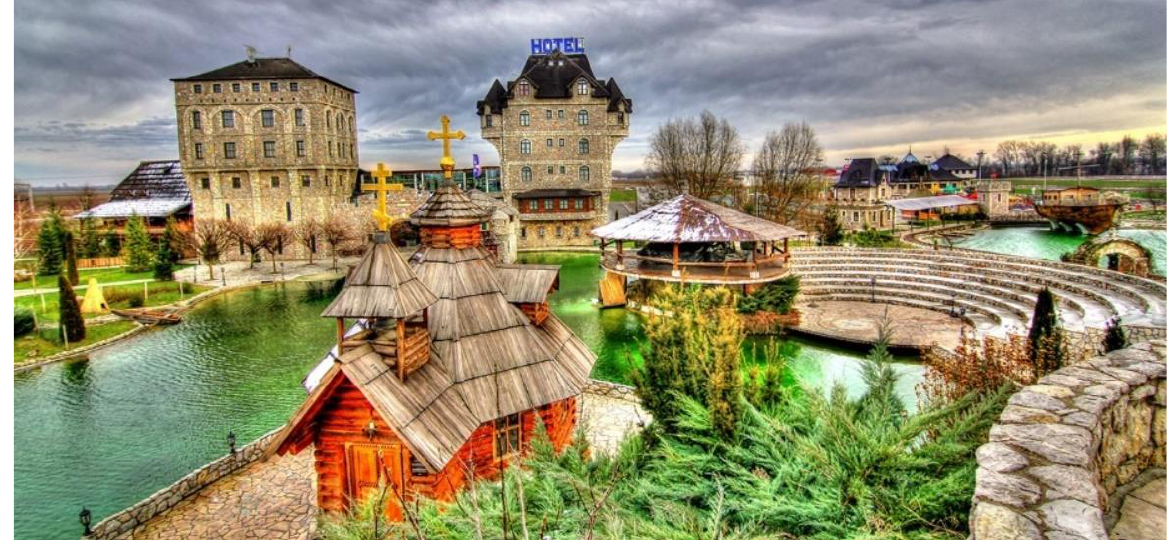
Figure 2. Ethno village Stanišići near Bijeljina (Source: